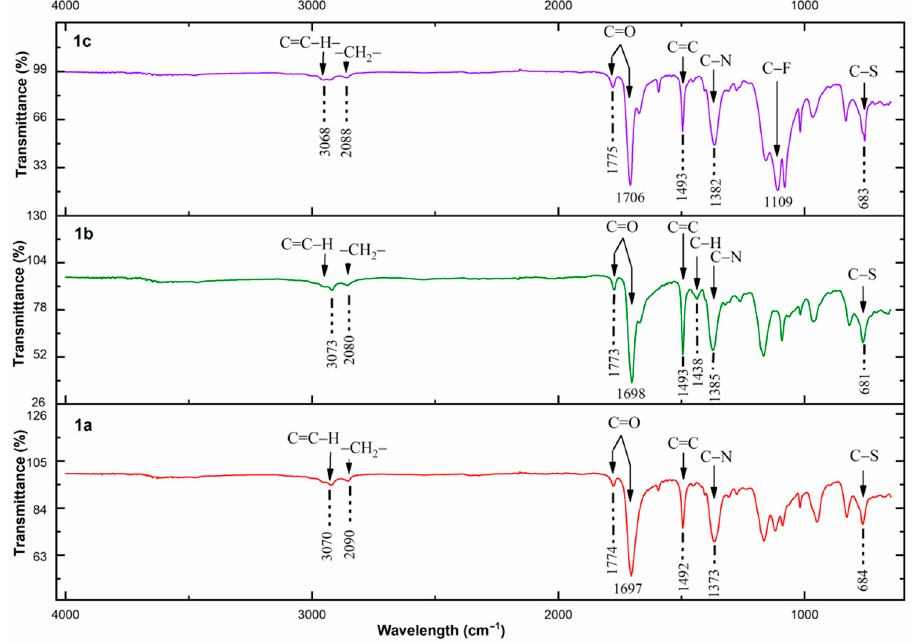
Figure 2. FT ‐ IR spectra of the thiol ‐ functionalized norbornene dicarboximide monomers. Figure 2. FT-IR spectra of the thiol-functionalized norbornene dicarboximide